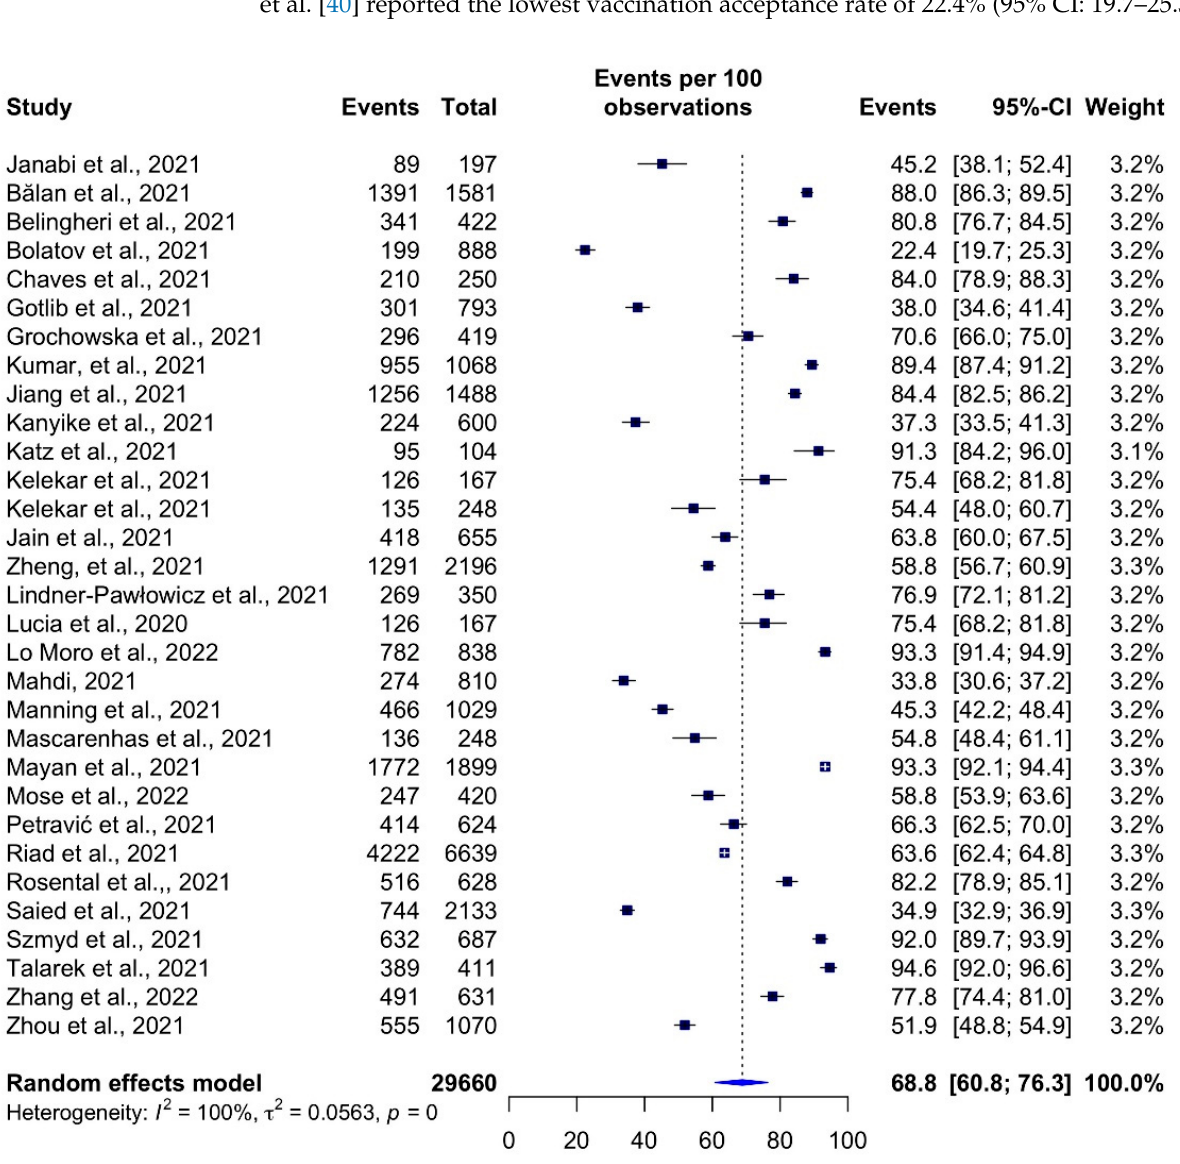
Figure 2. COVID-19 vaccine acceptance rates among healthcare students by study.